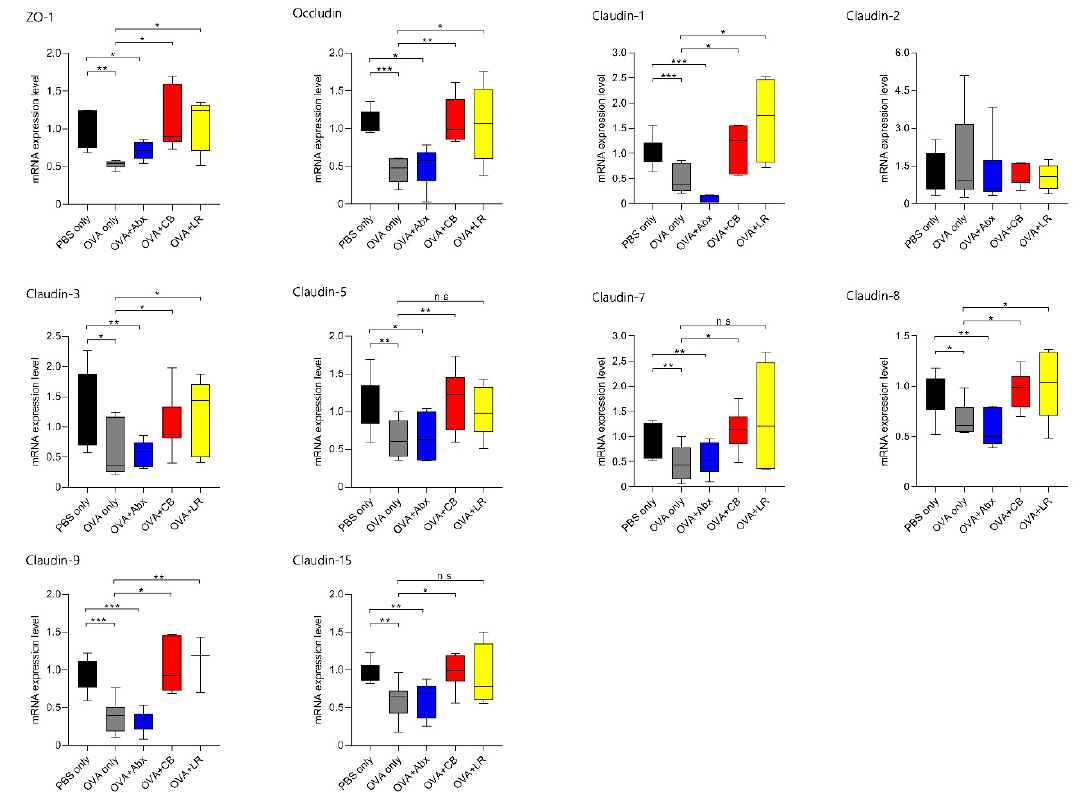
Figure 5. Total RNA was extracted from the jejunal tissue of rats, and the mRNA expression of TJ-related molecules was examined by real time PCR. Data are presented as the fold change in gene expression relative to the control (PBS only). ZO-1; occludin; claudin-1, -2, -3, -5, -7, -8, -9, and -15. Boxes represent the 25th to 75th percentiles; middle bar identifies the median; whiskers show the minimum and maximum ( n = 5–7 rats per group). * p < 0.05, ** p < 0.01, *** p < 0.001 determined by ANOVA with the Tukey–Kramer method. ns, no significance; Abx, antibiotics; CB, C. butyricum ; LR, L.